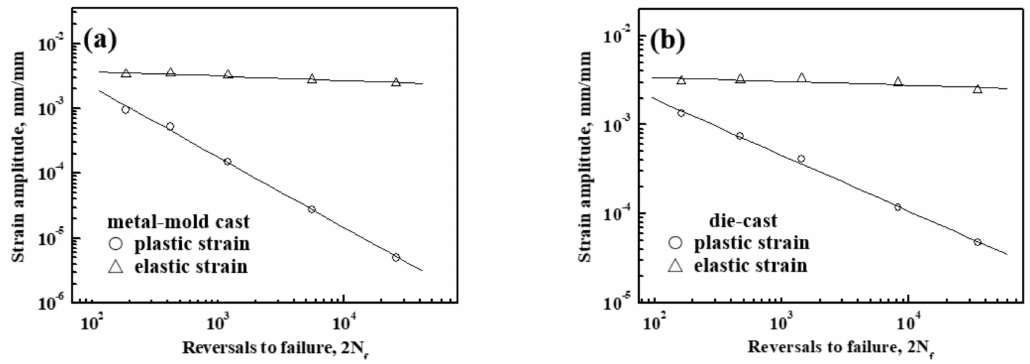
Figure 6. Strain amplitudes versus reversals to failure for Al-9Si-4Cu-0.4Mg-0.3Sc alloy. ( a ) metal-mold cast state; ( b ) die-cast